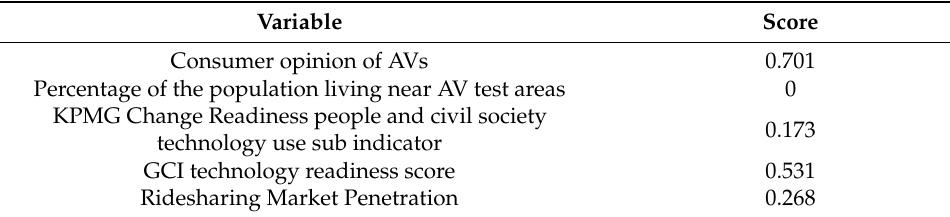
Table 2. Scores of Greece in Pillar IV variables.